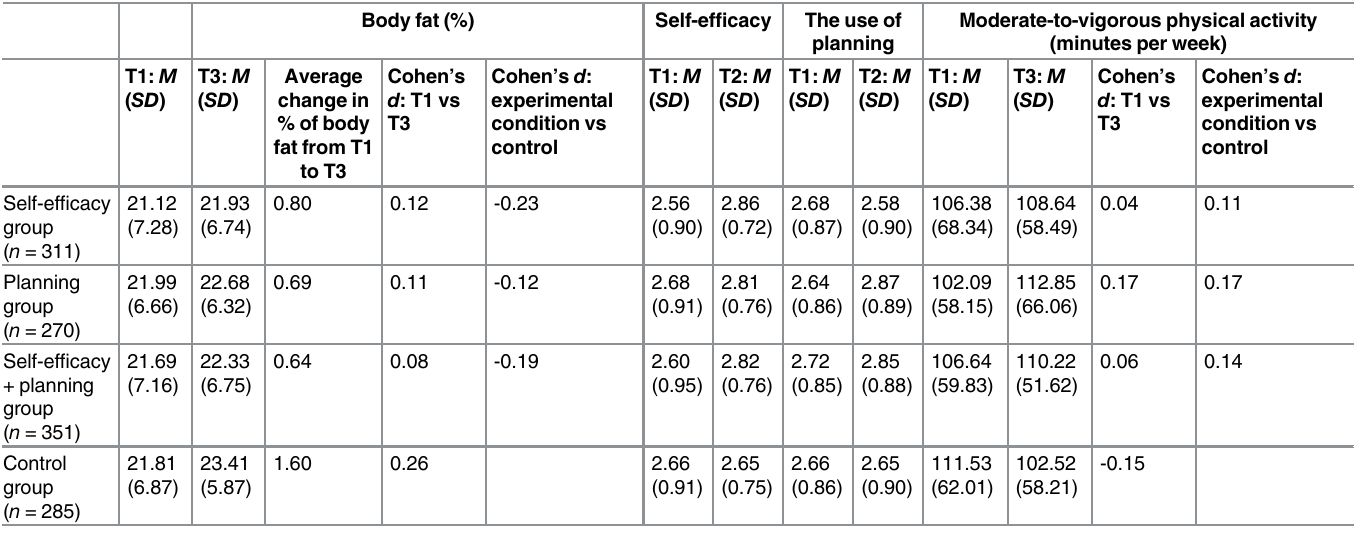
Table 2. Descriptive statistics in the four study groups: moderate-to-vigorous physical activity, percent of body fat, self-efficacy beliefs and use of planning. Body fat (%) Self-ef fi cacy The use of